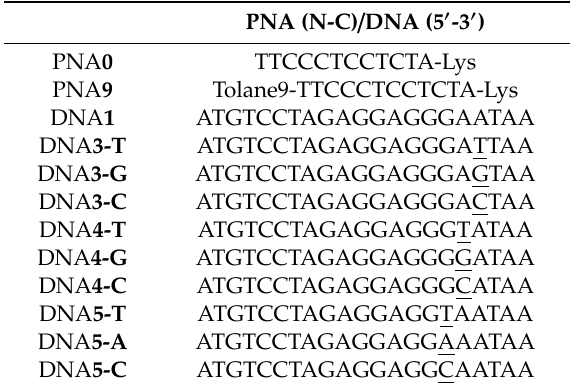
Table 4. PNA and DNA sequences used to study single base mismatch discrimination. The underlined sequences in DNA 3 , 4 , and 5 were the mismatched bases to both PNA 0 and PNA 9 .